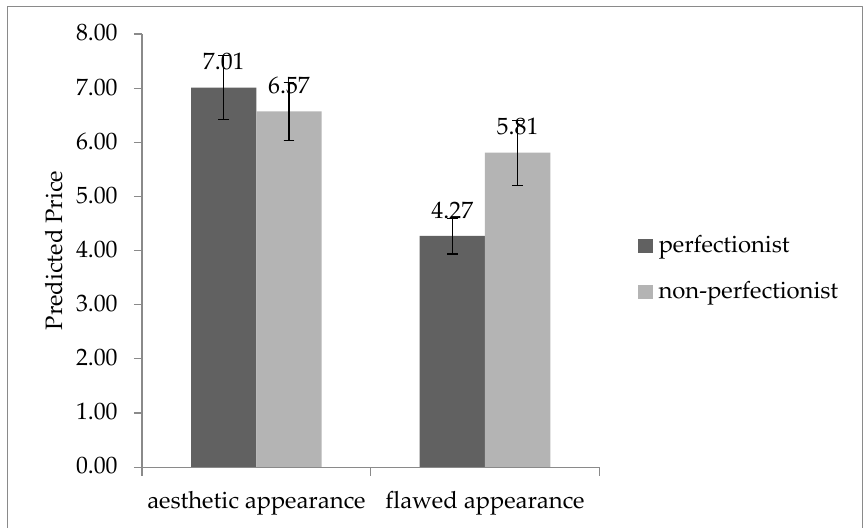
Figure 3. Purchase intention for products with aesthetic or flawed appearance according to perfec- tionists or non-perfectionists.